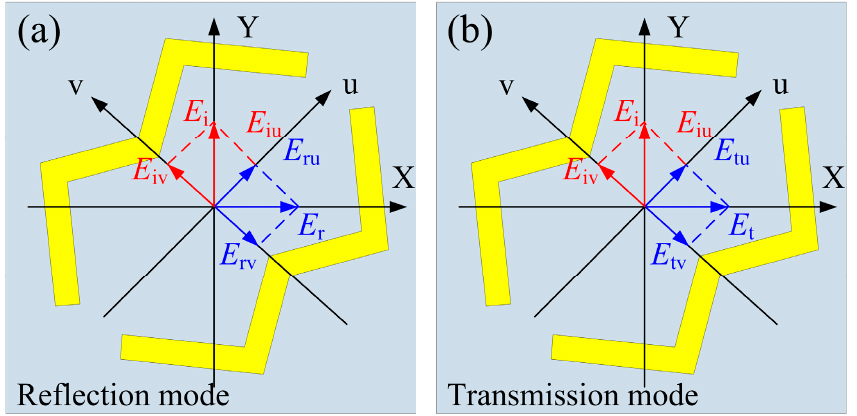
Figure 5. Schematic illustration of the conversion characteristics ( a ) Reflection mode; ( b ) Transmission mode.